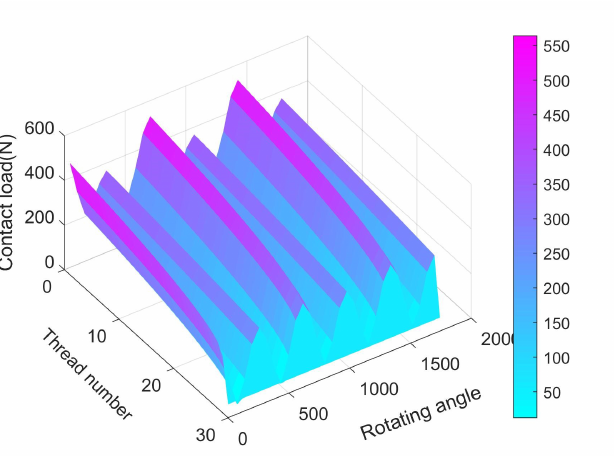
Figure 15. Contact load distribution cycling process with radial load of case